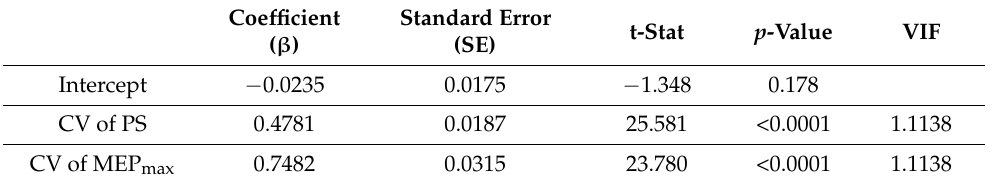
Table 2. GLM for predicting CV of MEP amp with CV of PS and MEP max as predictor variables. Coefficient Standard Error t-Stat p ( β ) (SE)